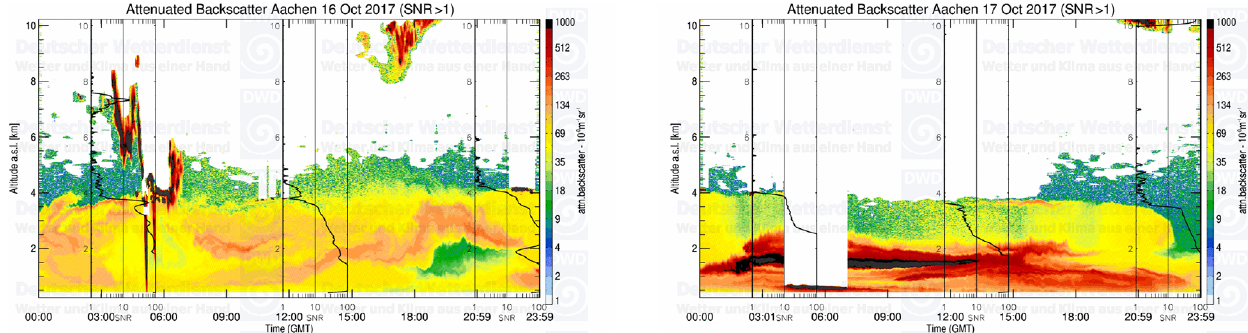
Figure B1. Time–height sections of β ∗ (z) at the ceilometer station near Aachen from 16 and 17 October 2017.